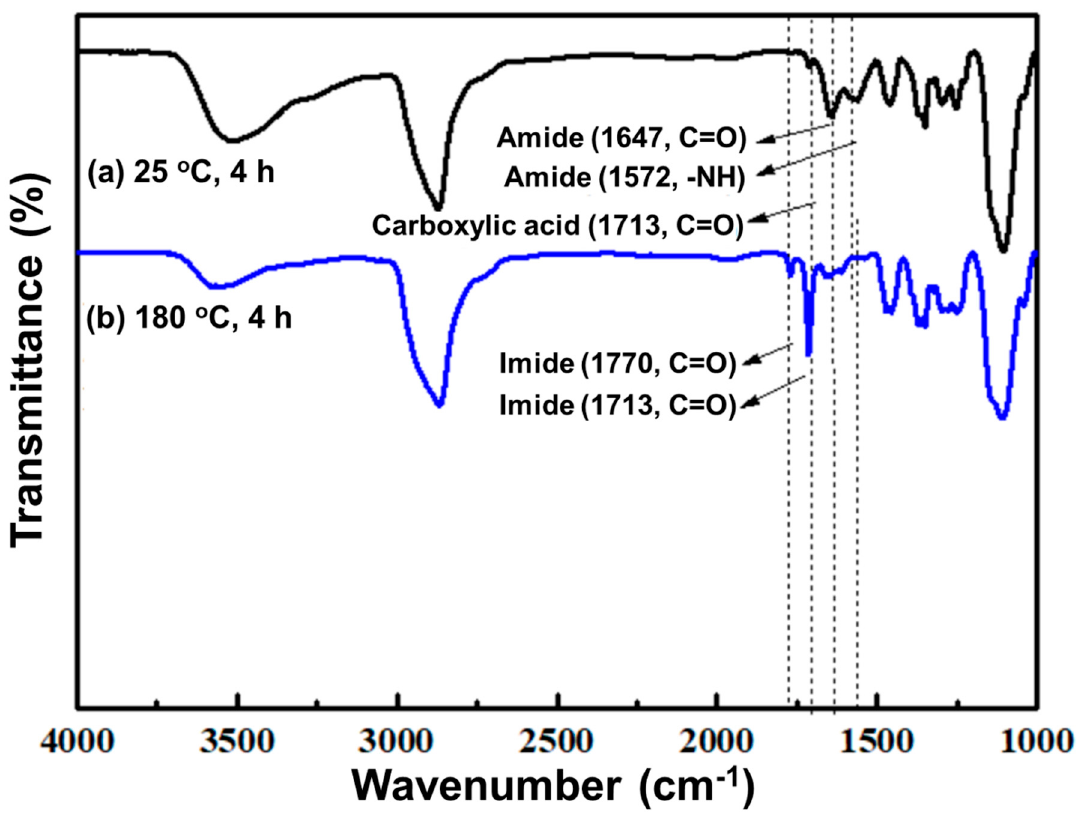
Figure 1. Fourier transform infrared (FTIR) spectra of POE-derived dispersants of ( a ) POE-amido acid intermediate and ( b ) POE-imide from amido acid to cyclized imide functionalities.